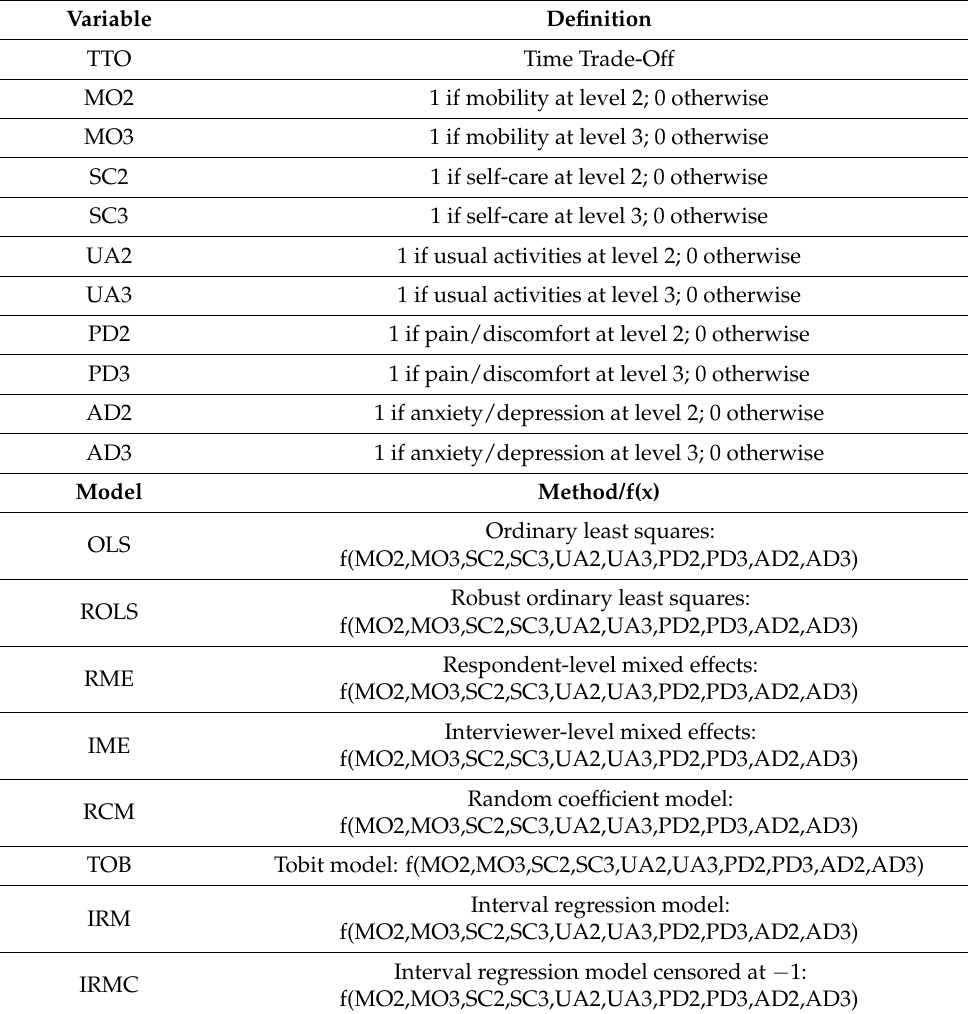
Table 1. Definition of variables and